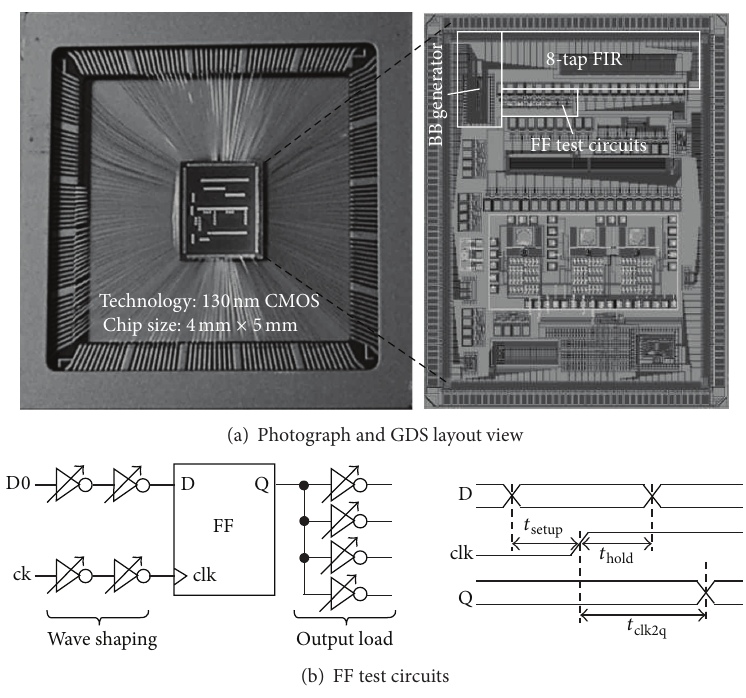
(b) FF test circuits Figure 9: Test chip with isolated FF test circuits in 130 nm technology.